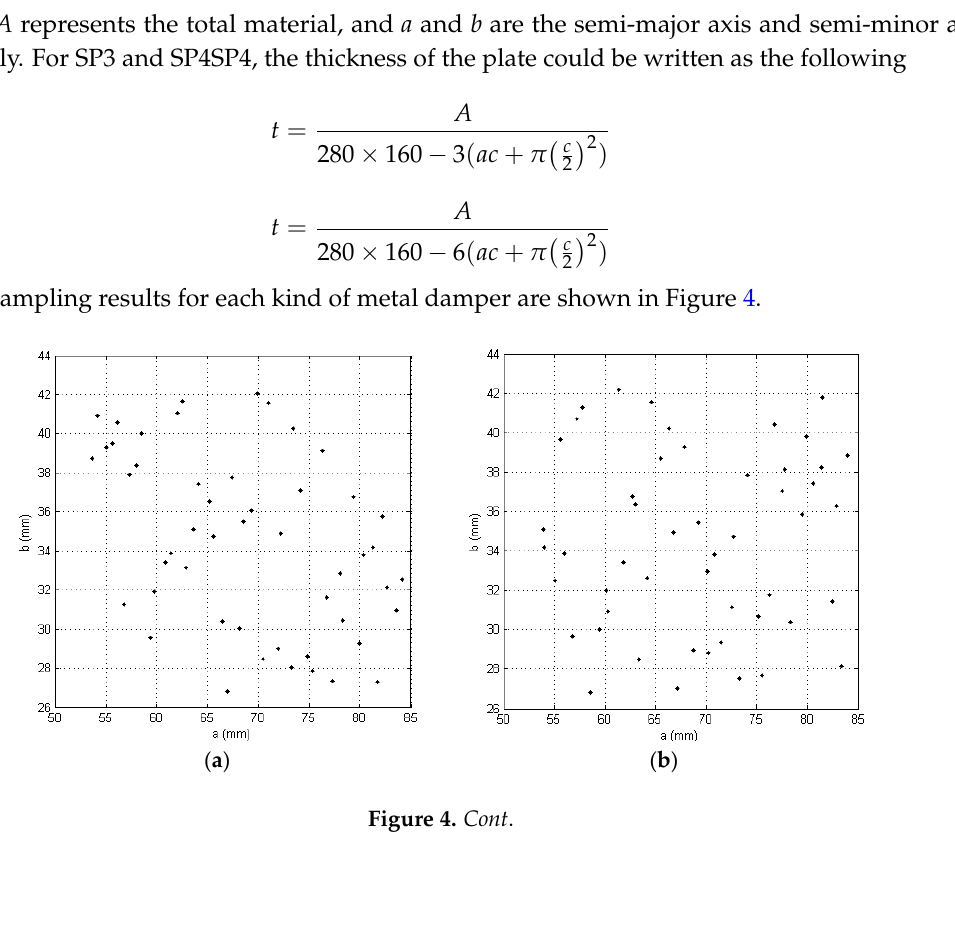
Figure 3. Load–displacement curve.